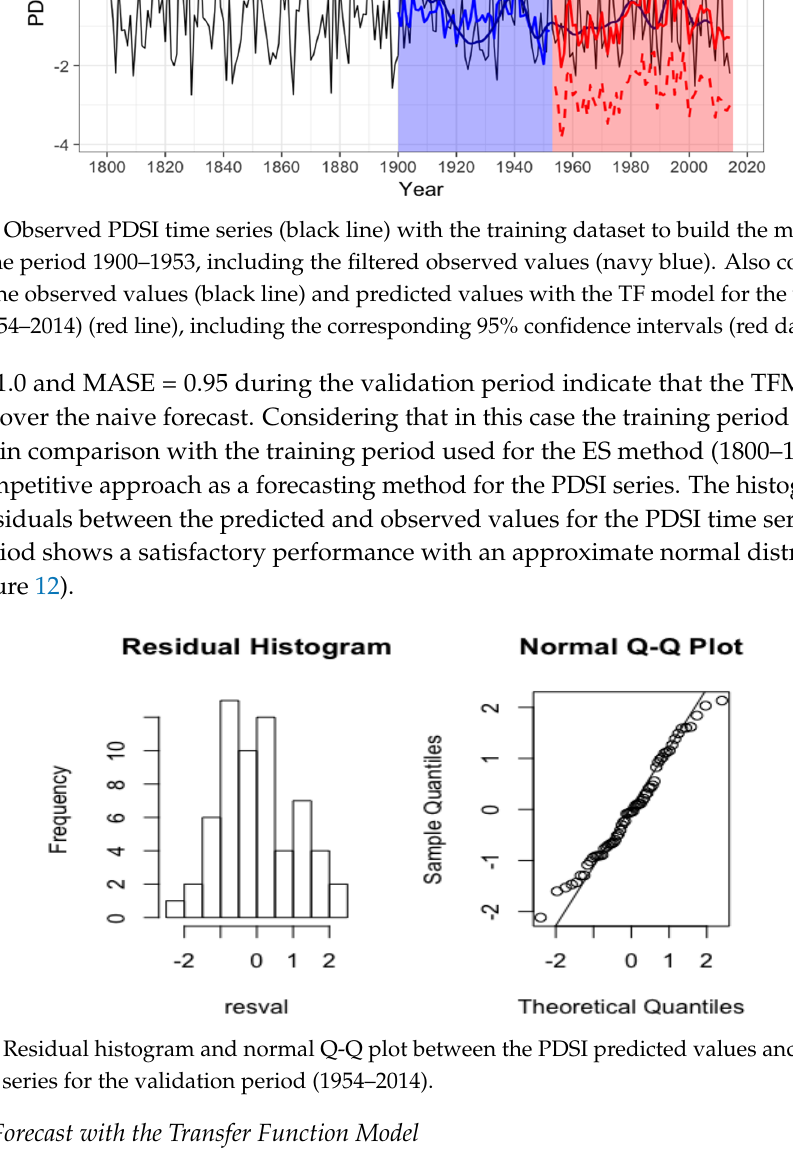
Figure 13. Observed PDSI time series (black line) with the simulation plume (grey lines) for the period 2015–2054, including the filtered observed series (navy-blue line), the median of the simulated values (thick grey line) and the 2.5% (bottom dashed line) and 97.5% quantile (top dashed line) of the simulated values. The inter-decadal cycles observed in the ensemble forecast from the ES approach (Figure 5) are not present in this case since a seasonal component was not considered in the model. Figure 14 compares the two approaches (ES ad TFM) in the validation and forecast periods. With ES, the projections of PDSI over four future decades (2015–2054) lie around the “incipient drought” class,